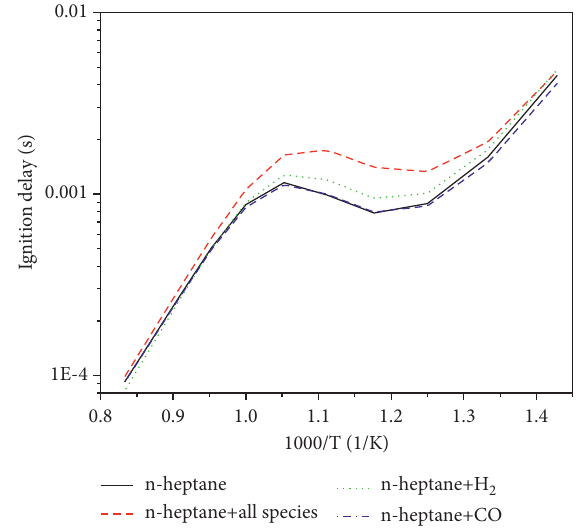
Figure 8: Ignition delay time of mixtures of different reforming species and n-heptane.